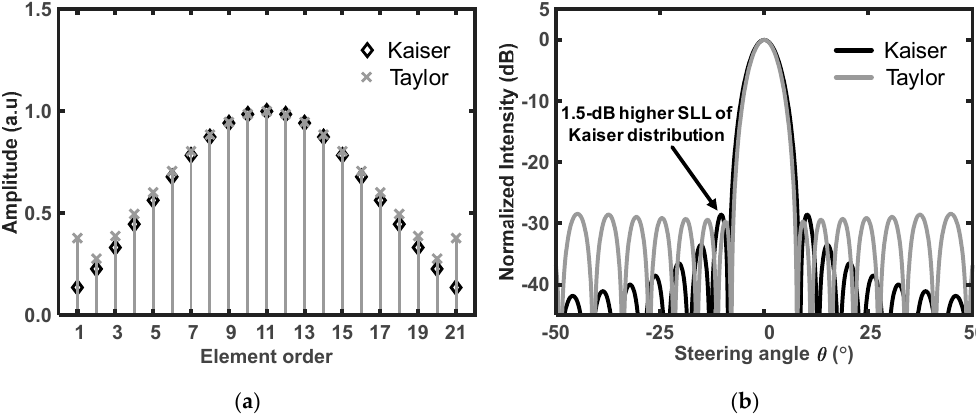
Figure 4. ( a ) Distributions of the Kaiser and Taylor window functions of 21 OPA elements. ( b ) Fourier transform (plotted on a decibel scale) of the Kaiser and Taylor window functions of the 21 OPA elements.